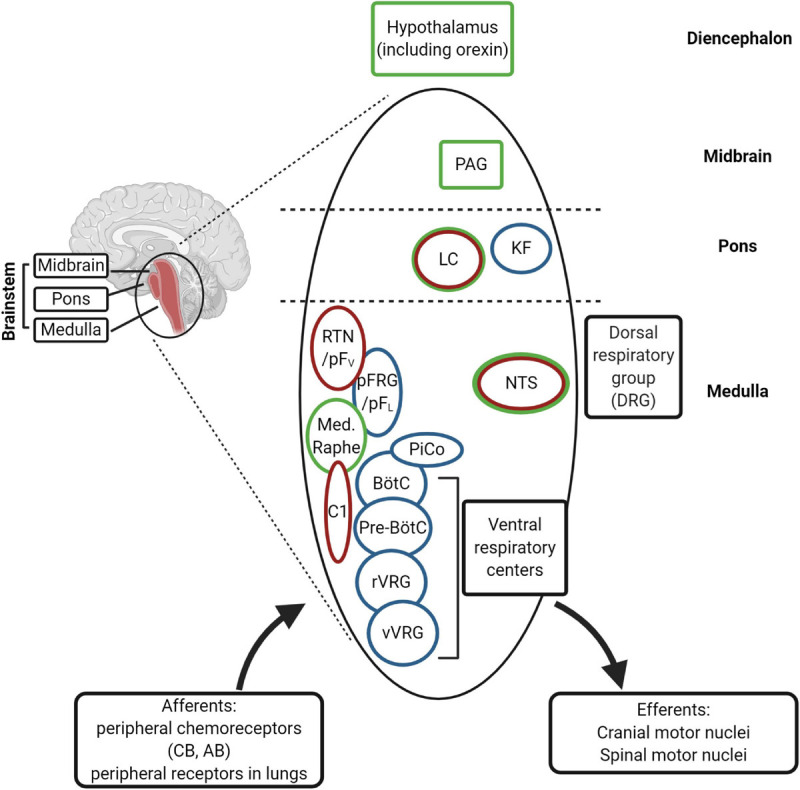
(Created with BioRender.com). Schematic diagram of the main respiratory centers in the brainstem. The rhythm generators are the pre-Bötzinger complex (pre-BötC) (inspiratory), the postinspiratory complex (PiCo), and lateral pFRG/RTN (expiratory). The RTN (retrotrapezoid nucleus) plays an important role in central chemosensitivity and receives inputs from NTS (nucleus of the solitary tract). The neural network integrates afferent information from the periphery with central chemoreception signals and activates efferent motor neurons [through rVRG (rostral ventral respiratory group) and cVRG (caudal ventral respiratory group), among others]. The rhythm generators receive inputs from serotonergic (medullary raphe), adrenergic (C1 neurons) and cholinergic neurons (Kolliker-Fuse nucleus, KF) of the ponto-medullary regions for modulation of the respiration in the different behavioral states, including sleep and wakefulness. The medullary respiratory centers are also connected to higher centers in the pons (LC, locus coeruleus), in the midbrain (PAG, periaqueductal gray) and diencephalon (hypothalamus). The nuclei expressing Phox2b are indicated in red and those expressing PGR and/or progesterone-sensitive in green. CB, carotid body; AB, aortic bodies.